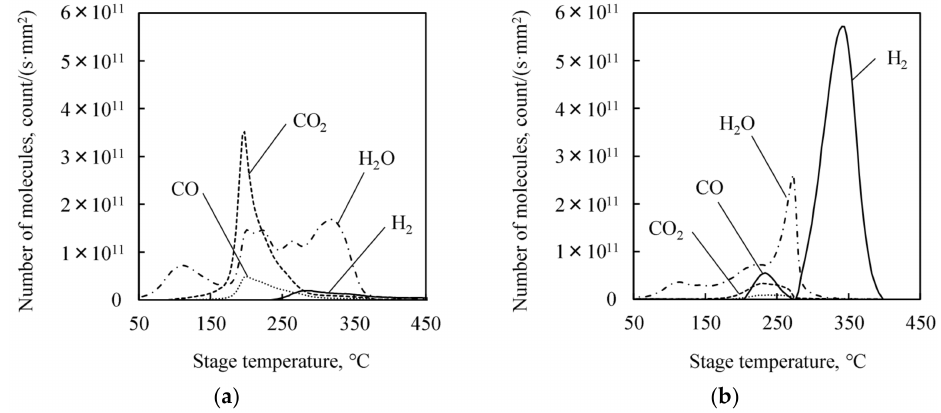
Figure 10. TDS spectra of the treated Cu films after exposed to the atmosphere for 1 h. ( a ) Citric acid treated Cu film. ( b ) Atomic hydrogen treated Cu film.